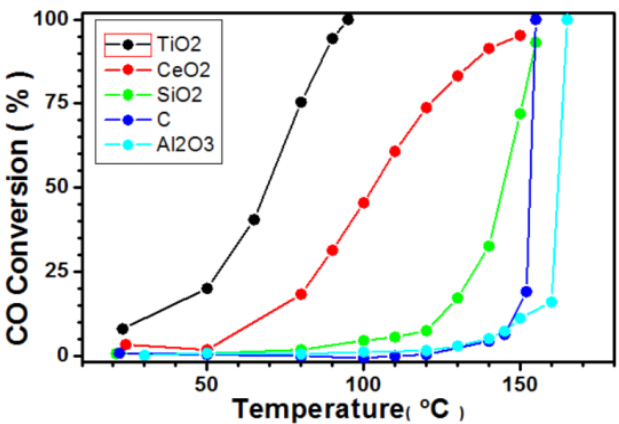
Figure 7. CO conversion for catalytic CO oxidation over Pd 48 Cu 52 alloy NPs on different supports: TiO 2 (black), CeO 2 (green), SiO 2 (red), carbon (blue) and Al 2 O 3 (cyan).